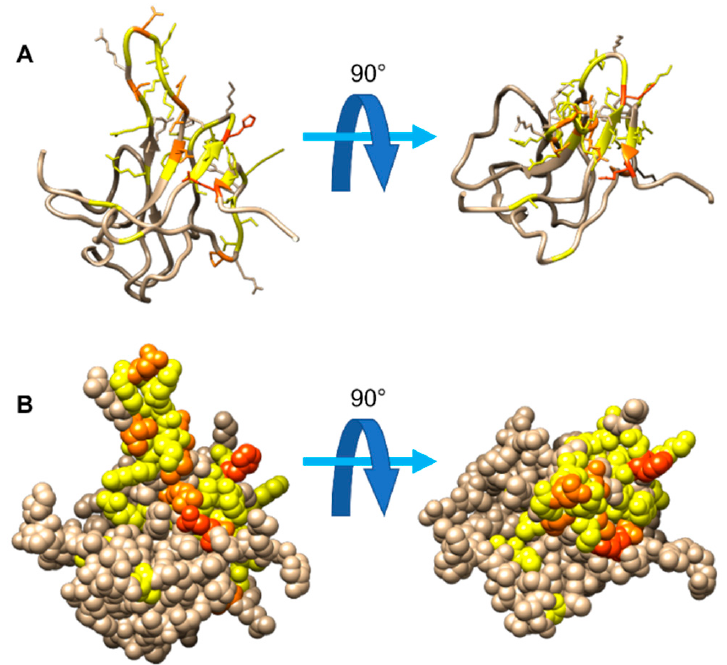
Figure 5. Mapping of the residues displaying the strongest perturbation in different 2D spectra (2D HN (backbone region), 2D HN (arginine region), 2D CON, 2D CACO, 2D CBCACO, and 2D HC (aromatic region)) at a molar ratio of 1:1.2 of NTD:EP. Panel ( A ) reports the protein in two different orientations, rotated by 90 ◦ , one with respect to the other; the heavy atoms of the perturbed residues are displayed as well. Panel ( B ) shows the same protein orientations with the models represented in a space-filling way. The color-coding is the following: residues which are found to be perturbed in a single experiment (yellow), in two experiments (orange), and in three or more experiments (red).